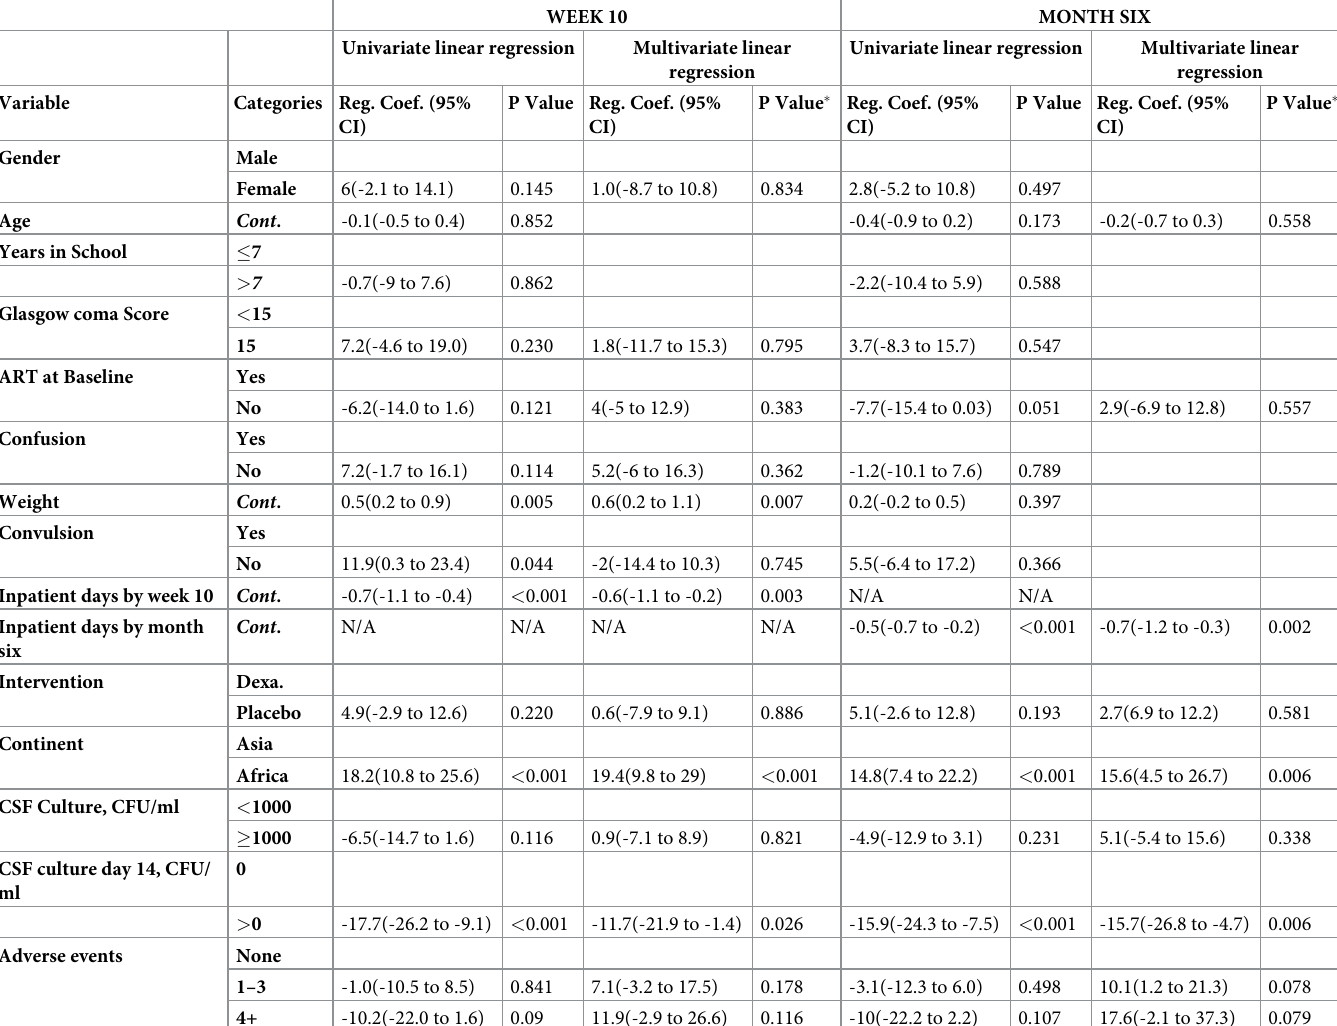
Table 3. Quality of Life and associated factors at 10 weeks and 6